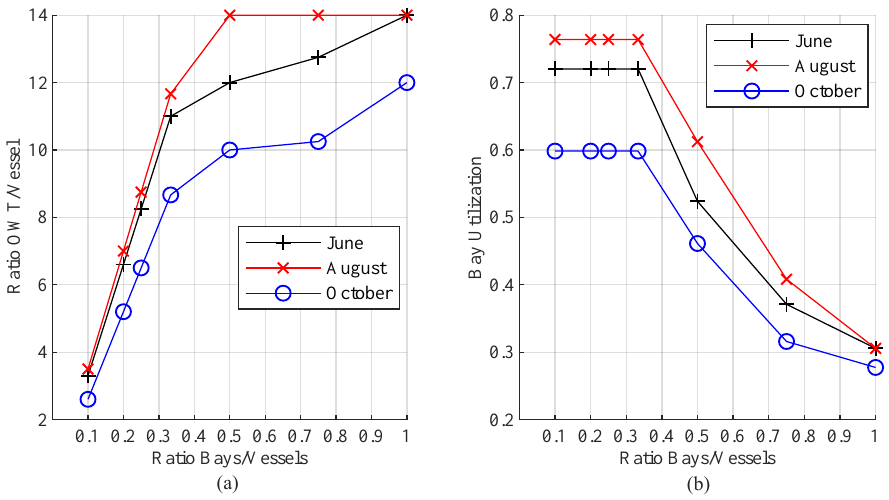
Figure 7. Absolute number of finished turbines per vessel ( a ) and normalized bay use ( b ) for different ratios of bays and